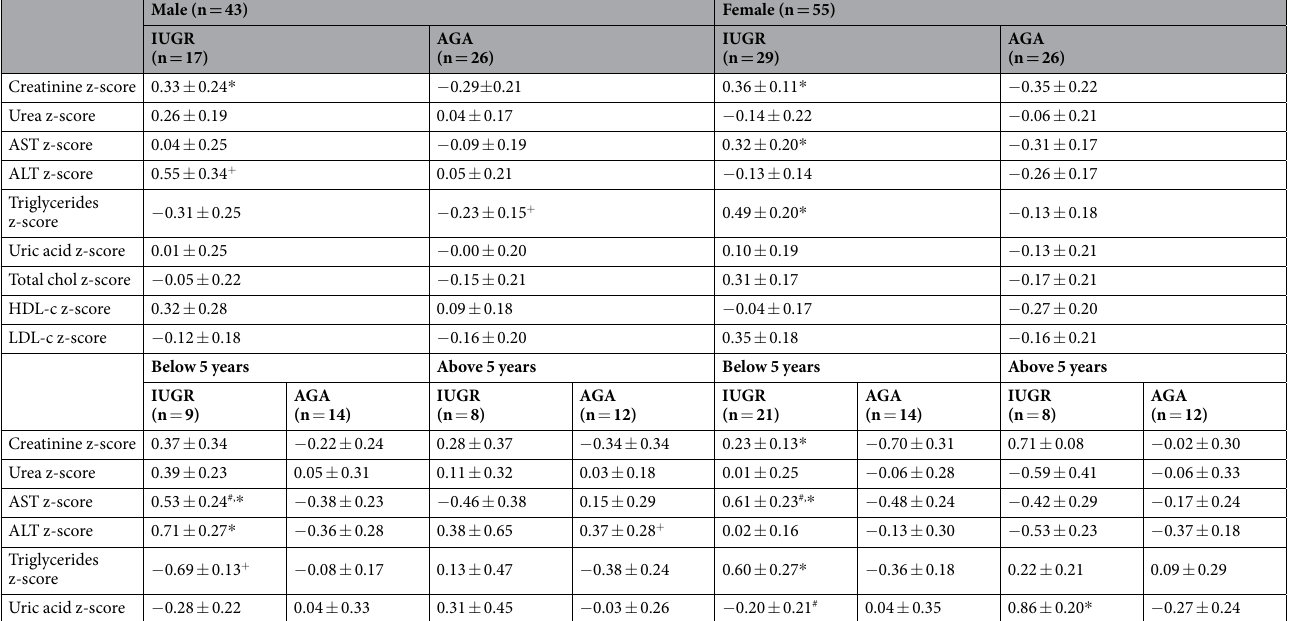
Table 4. Comparison of biochemical parameters between children born IUGR and AGA at the observation time expressed as mean ± S.E. Statistical comparisons were performed with multiple factors ANOVA. * denotes statistically significant difference from the respective AGA group. # denotes statistically significant difference from the respective group aged > 5 years old. + denotes statistically significant difference from the respective female group.